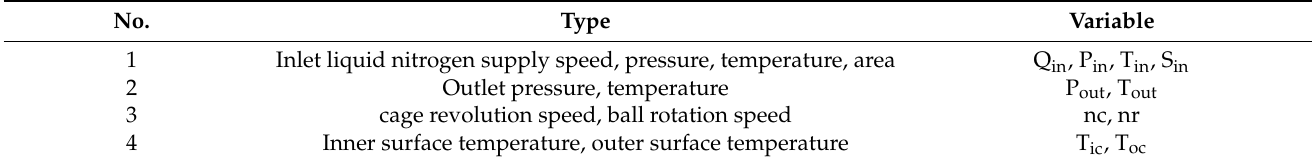
Figure 22. A coupled fluid-thermal finite element model. Table 4. Flow velocity, pressure, and temperature boundary conditions.